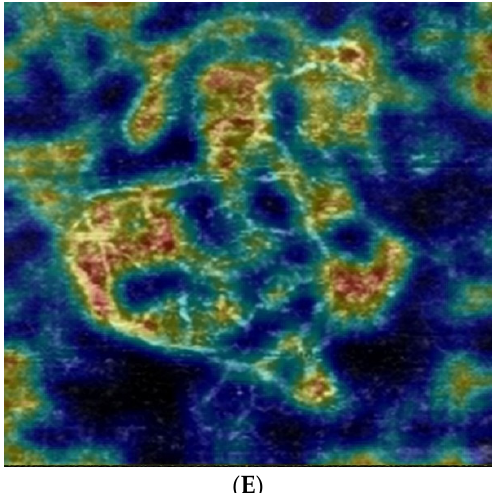
Figure 1. ОСТ -angiography, Eye Clinic ”Zrenie“; Nidek OCT-A RS-3000) Advance 2. ( A ) NV type “Sea fan”; ( B )NV type “Medusa”; ( C )NV type “Dead tree”; ( D ). NV type “Lace”; ( E ) NV type “Fil- aments”.